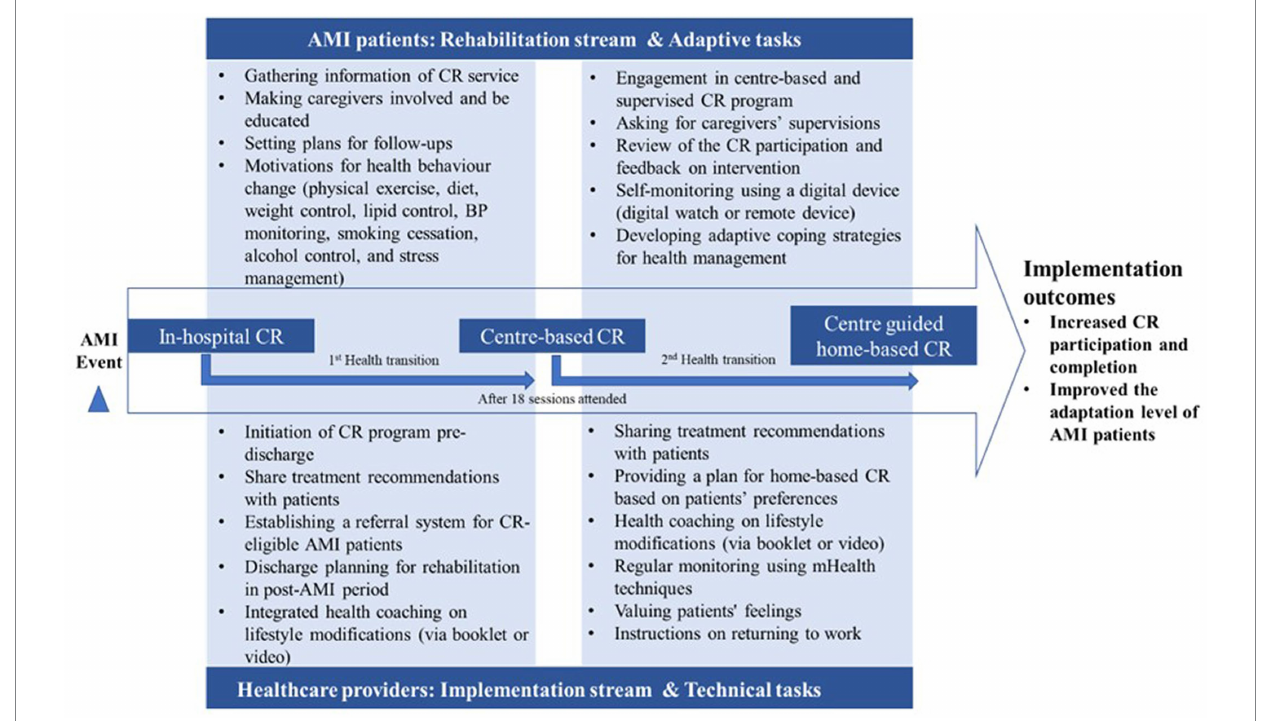
FIGURE 3 The integrated flowchart with three-phase performance